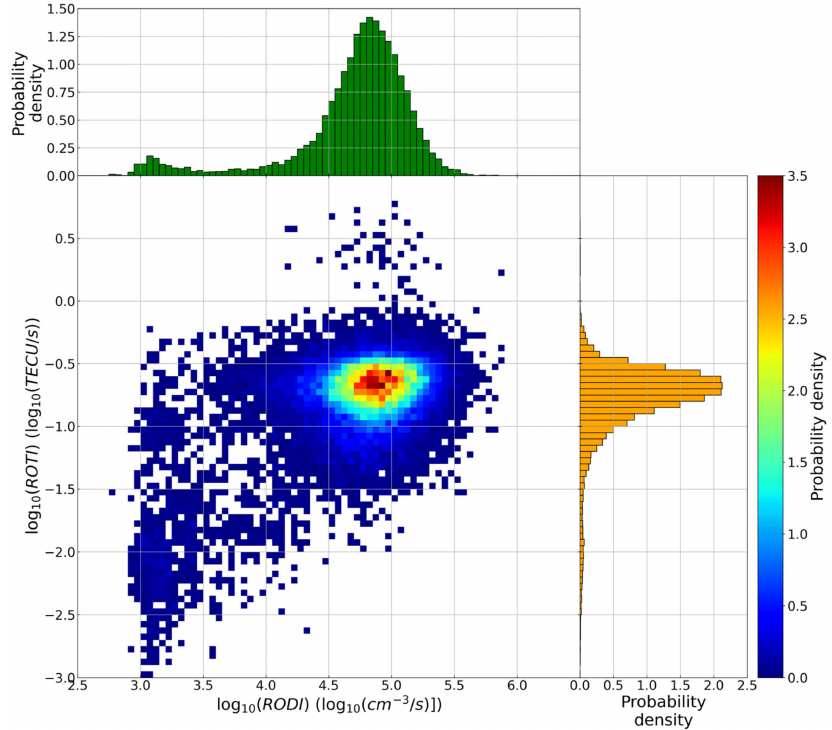
Figure 10. Same as Figure 9 but selecting only GPS LoL events occurred for |QD latitude| > 45 ◦